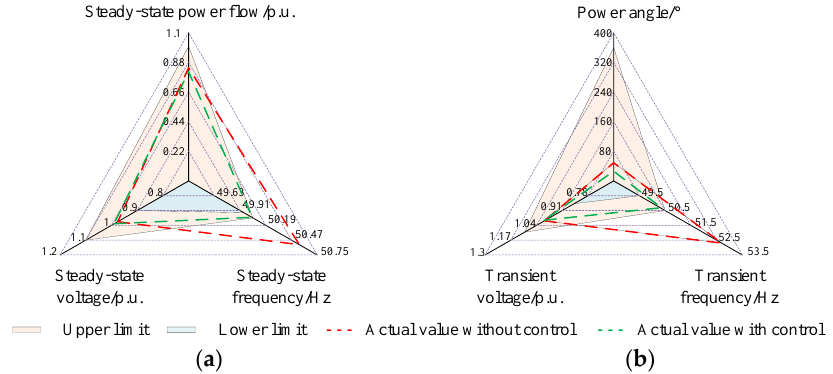
Figure 13. Static and dynamic security indices of region A. ( a ) Static indices; ( b ) Dynamic indices corresponding to the maximum transient frequency and voltage.